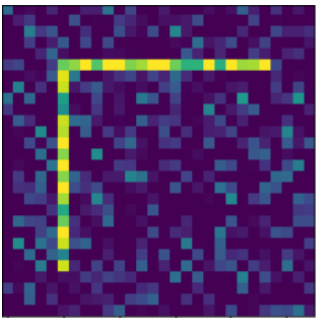
Figure 22. Resized object, with level 2